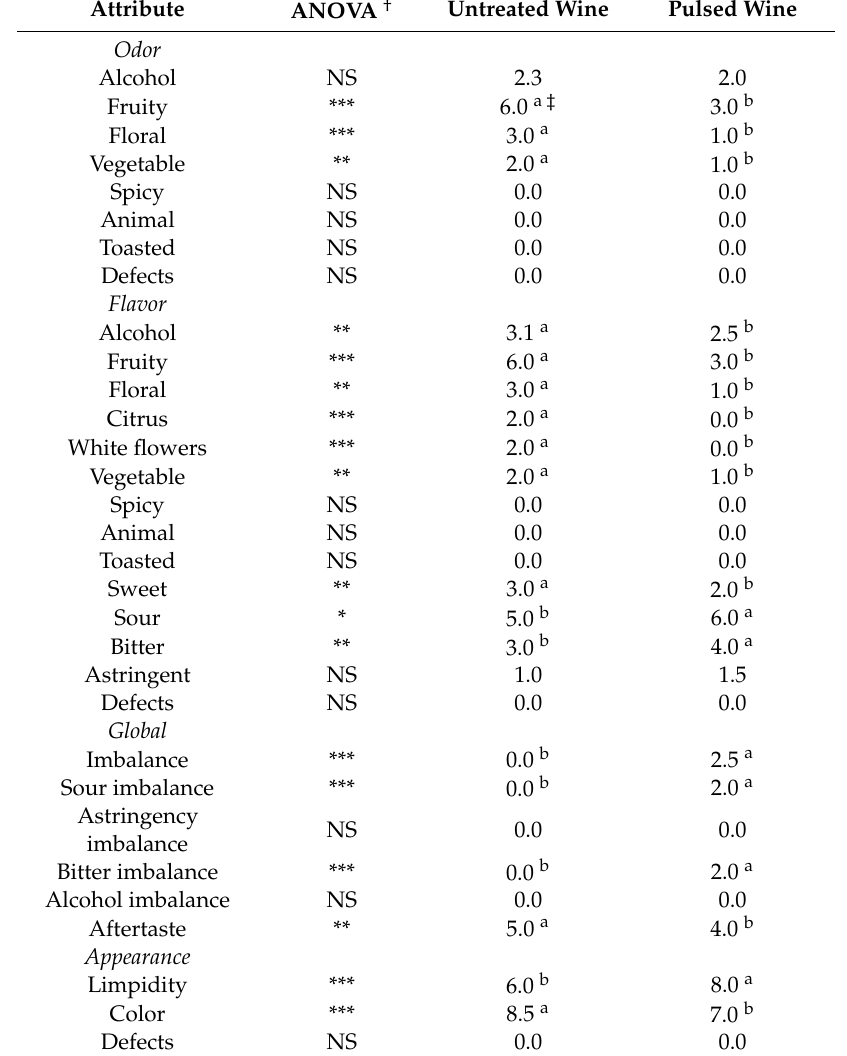
Table 3. Sensory descriptive analysis of wine samples subjected to pulsed light (10.7 J / cm 2 ).